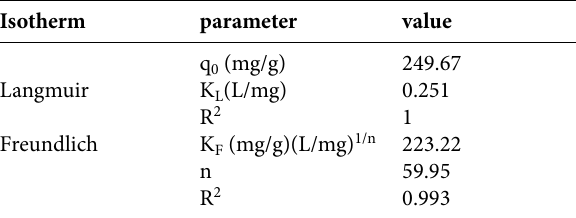
Table 3. Constants and parameters of the Langmuir and Freundlich isotherm models for the sorption of sodium ion from aqueous solu- tion using activated carbon